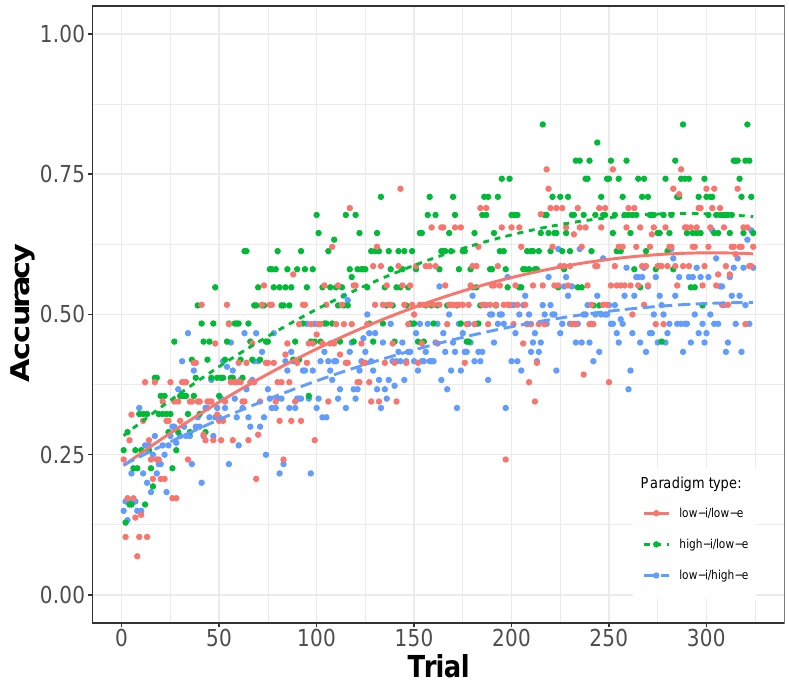
Figure 7: Mean accuracy by trial for each of the three paradigm types (col- lapsing the two low-i/high-e paradigms). Points indicate the average accuracy across participants for each trial. Lines show quadratic polynomial curves pre- dicting accuracy by trial number for each paradigm type. Learning is worst for the low-i/high-e and best for the high-i/low-e paradigms